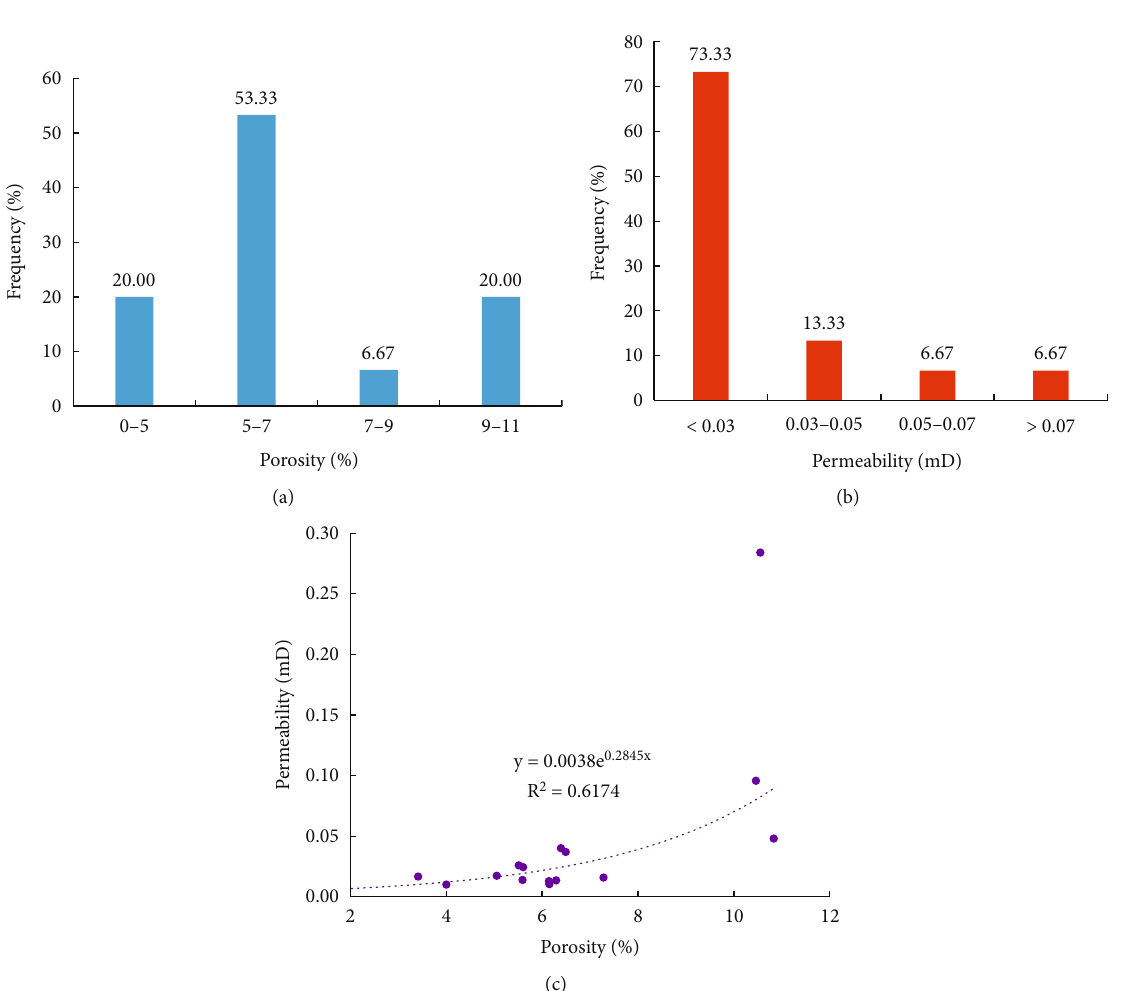
sublayer of Yanchang Formation. (a) Porosity and (b) permeability distributions and (c) 3